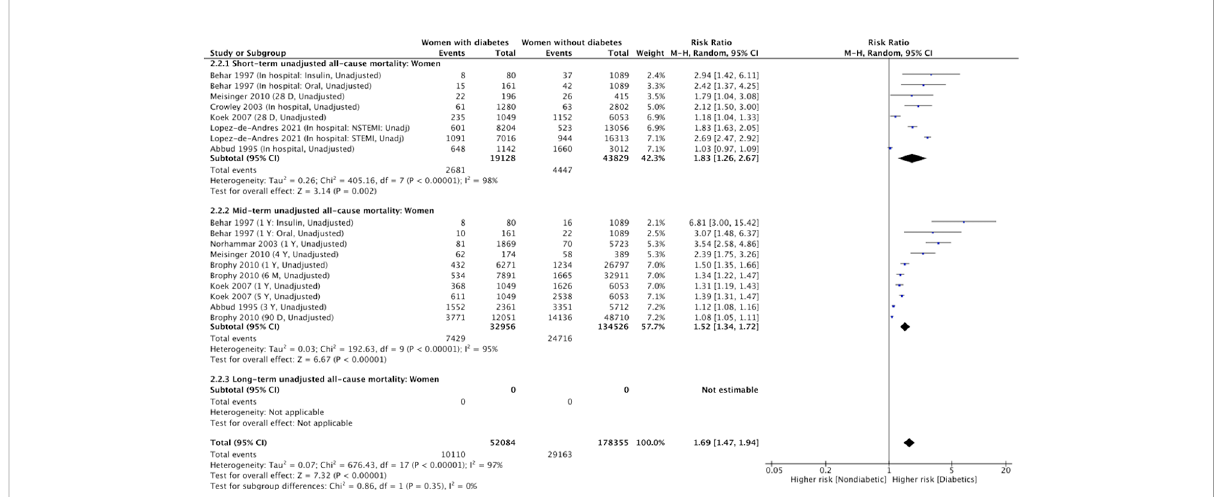
FIGURE 4 Summary of unadjusted short-term, mid-term and long-term risk estimates for post- AMI all-cause mortality in women with diabetes compared to women without diabetes. (Data extracted from 8 studies and including of total of 52, 084 women with diabetes and 178, 355 women without